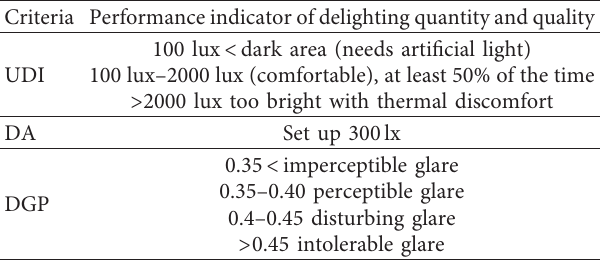
Table 6: The performance indicators of visual comfort used in this study. Criteria Performance indicator of delighting quantity and quality